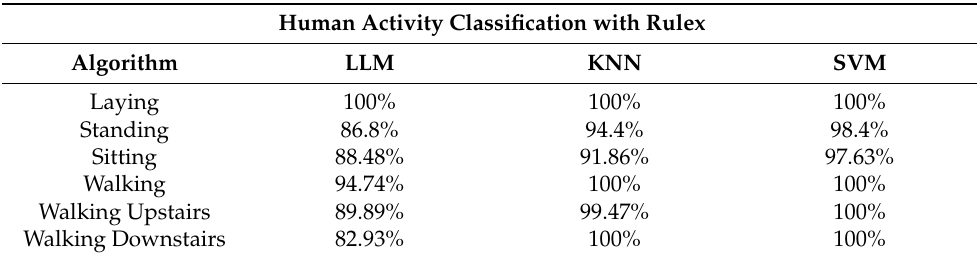
Table 1. Forecast accuracy for the Smartphone Activity Detection application.